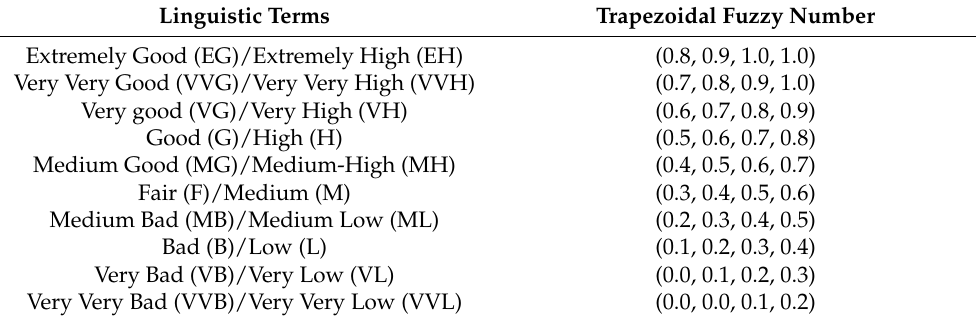
Table 2. Linguistic terms for rating the alternatives. Linguistic Terms Trapezoidal Fuzzy